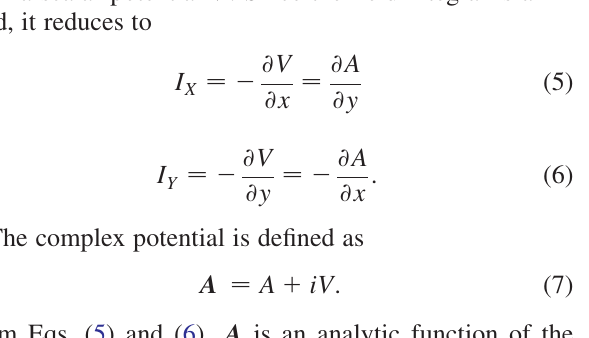
FIG. 1. Stretched wire field integral measurement (a) and second field integral measurement